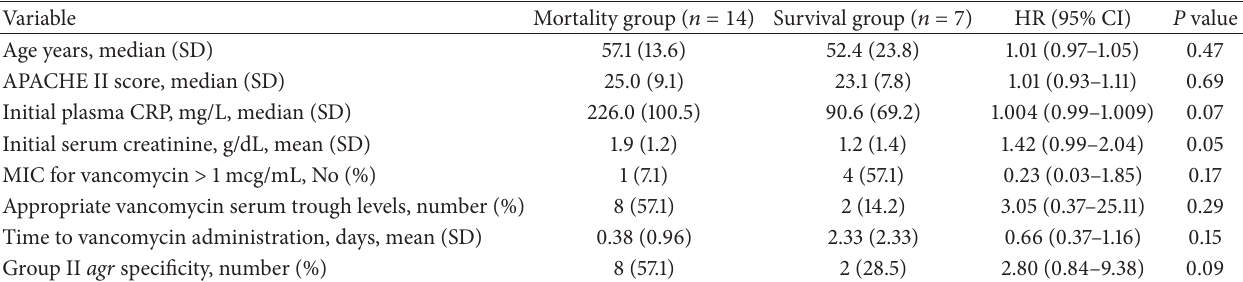
Table 2: Univariate Cox regression analysis of risk factors for in-hospital mortality in critically ill patients with MRSA bacteremia treated with vancomycin.